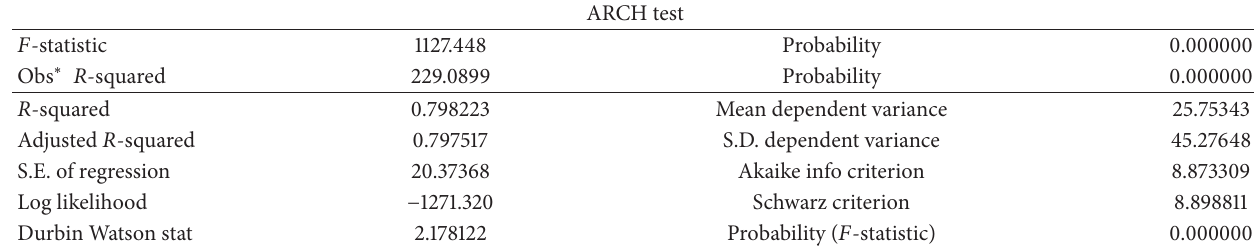
Table 1: ARCH test.